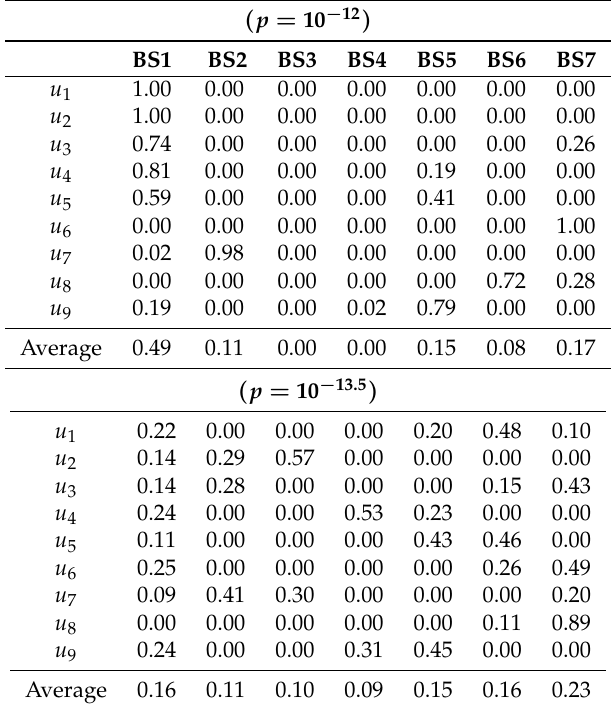
Table 1. Equilibrium for cluster heads in BS1 when p = 10 − 12 and p = 10 − 13.5 . ( p = 10 − 12